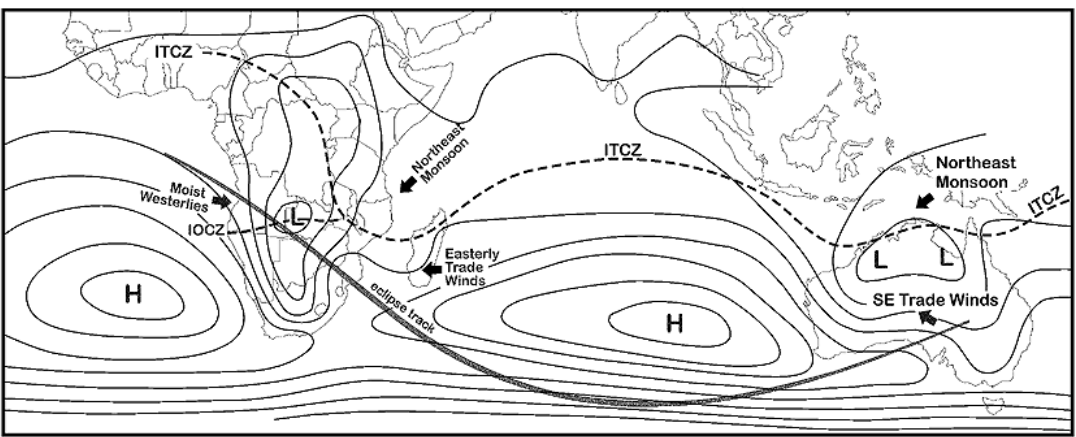
Figure 3. Global pressure and weather systems [49].